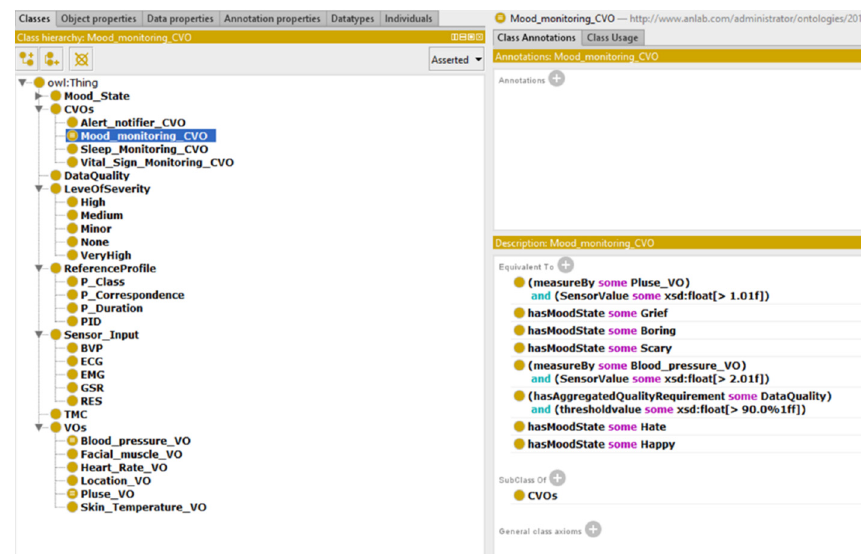
Figure 19. TMC application ontology model classes hierarchy.